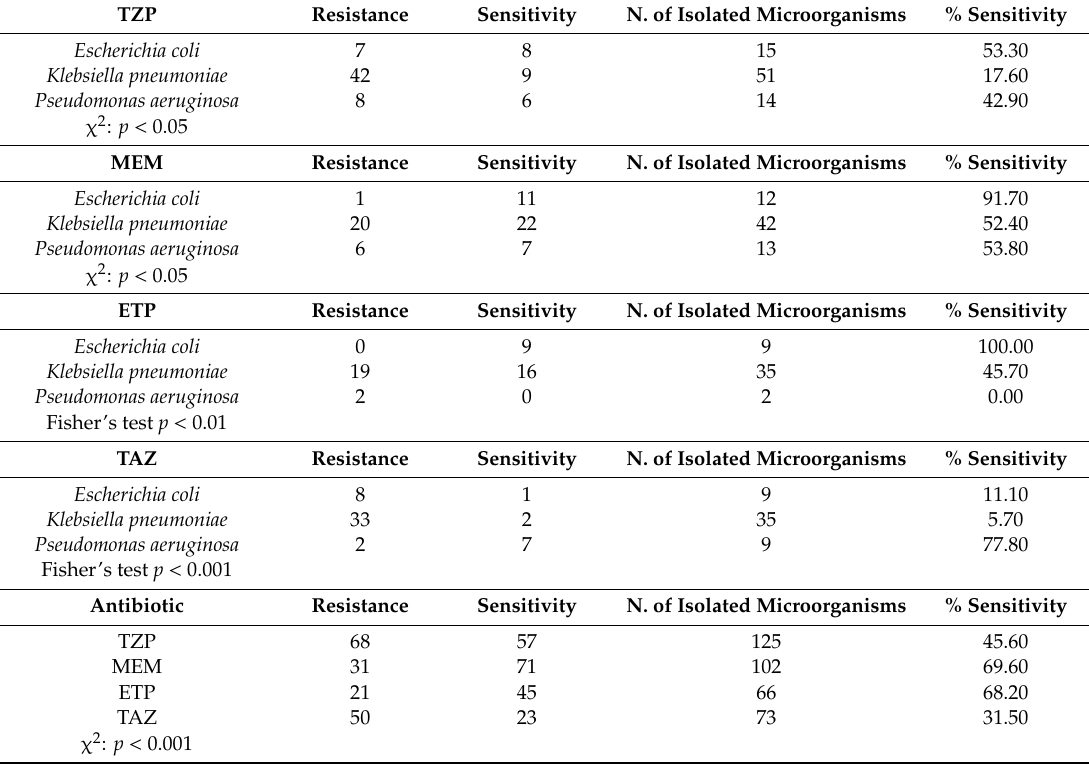
Table A3. Patients treated with ceftazidime / avibactam: profile of the sensitivity and resistance of microorganisms versus di ff erent types of antibiotics.